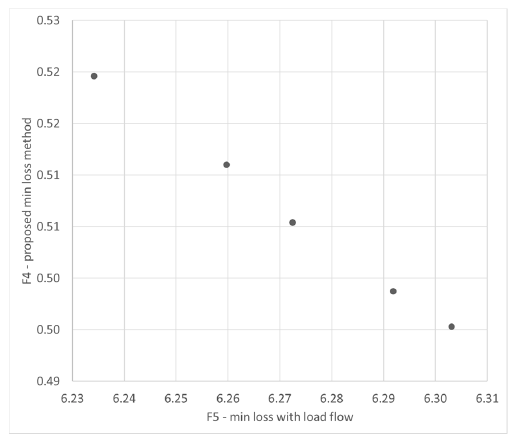
Figure 7. The Pareto frontier for the pair F5–F4.